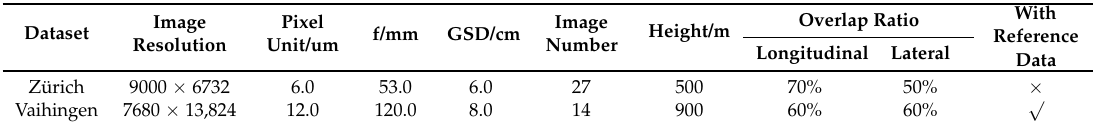
Table 1. Data description of test image datasets.